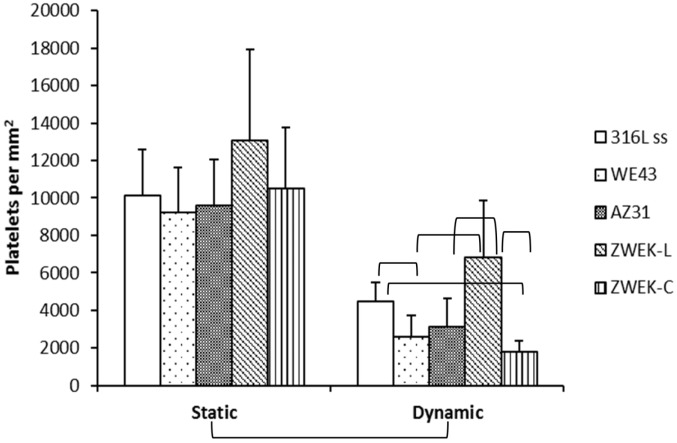
Platelets adhesion rate at both static and dynamic condition.Parenthesis mean significant differences between groups (P<0.05).